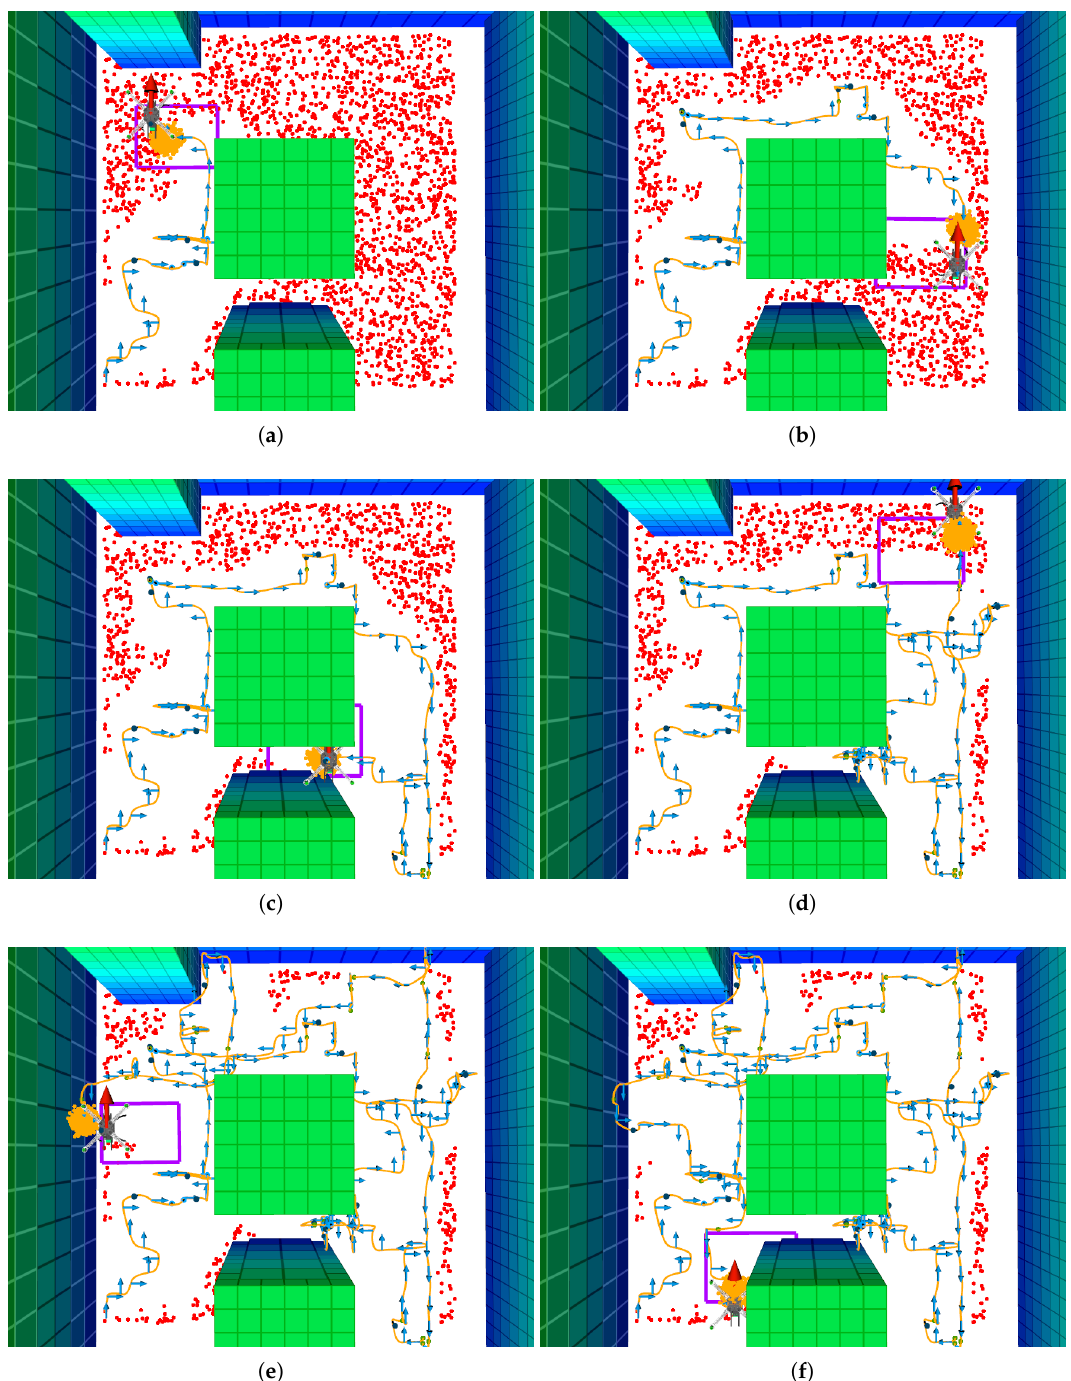
Figure 13. Example traversed path in a real flight test if a victim is undetected under a uniform belief cluster. ( a ) Traversed path at time step k = 30; ( b ) k = 55; ( c ) k = 75; ( d ) k = 105; ( e ) k = 150; ( f ) k =